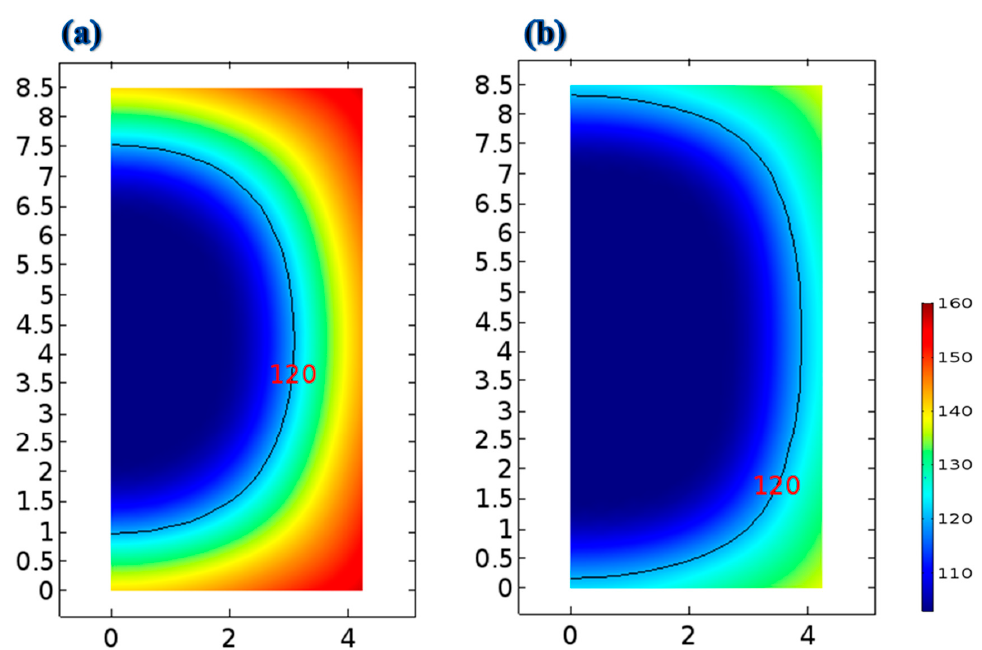
Figure 9. Temperature distributions in the strip after 9 min of frying: ( a ) without the temperature-step frying approach at 170 °C and ( b ) with the temperature-step frying approach at 170 °C.